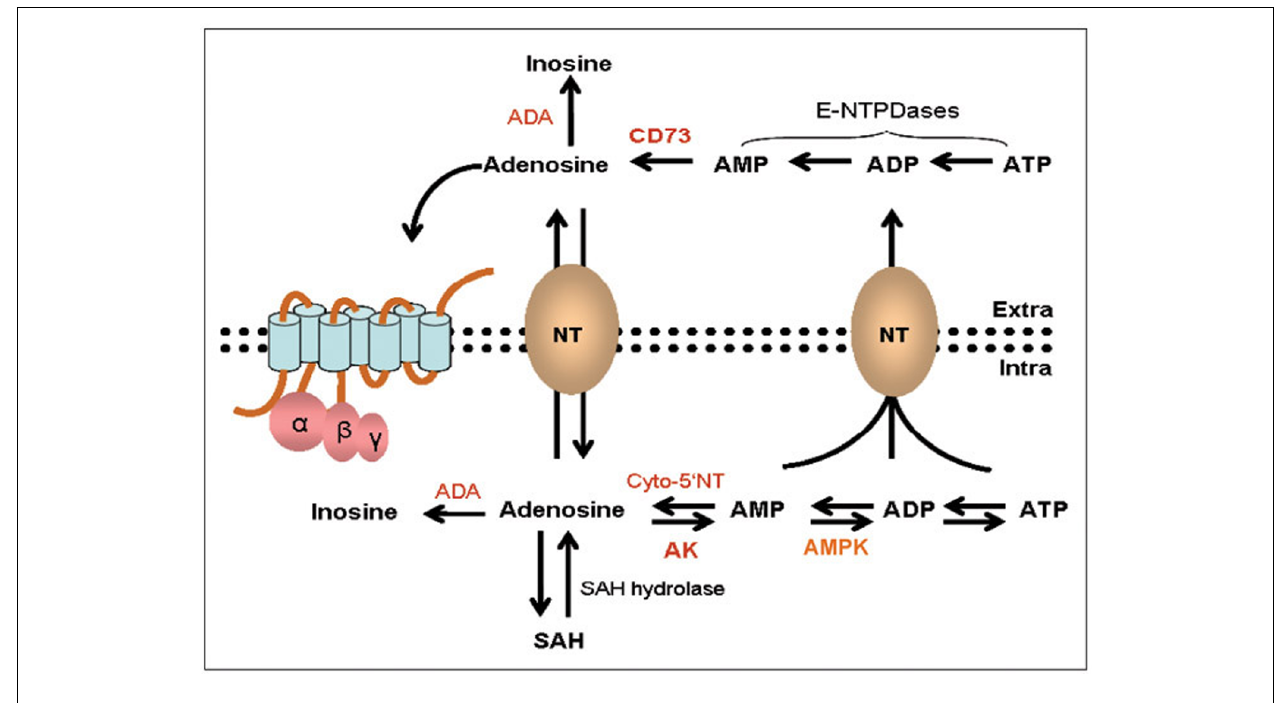
FIGURE 1 |Adenosine synthesis and metabolic pathways inside and outside of a cell. Within the cell ATP and adenosine are continually recycled depending on energy requirements via a series of dephosphorylation and phosphorylation steps mediated by enzymes such as cytosolic 5 (cid:2) -nucleotidase (cyto-5 (cid:2) NT), adenosine kinase (AK), and AMP kinase (AMPK). Under physiological conditions the rate limiting enzyme is AK. Adenosine can also be generated from the hydrolysis of S -adenosyl-homocysteine